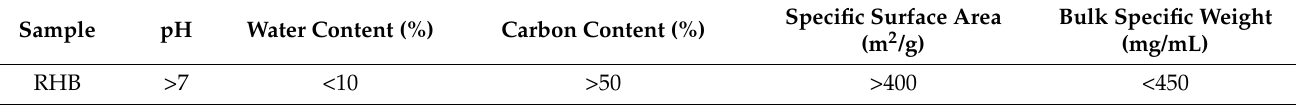
Table 4. Basic technical indicators of rice husk biochar.